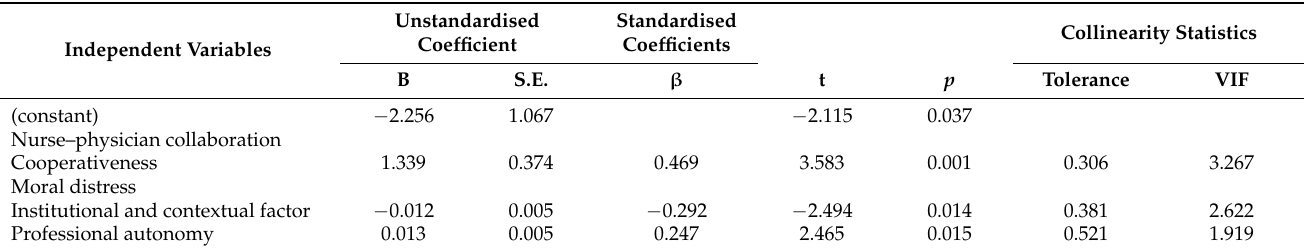
Table 4. Impact of nurse–physician collaboration, moral distress, and professional autonomy on job